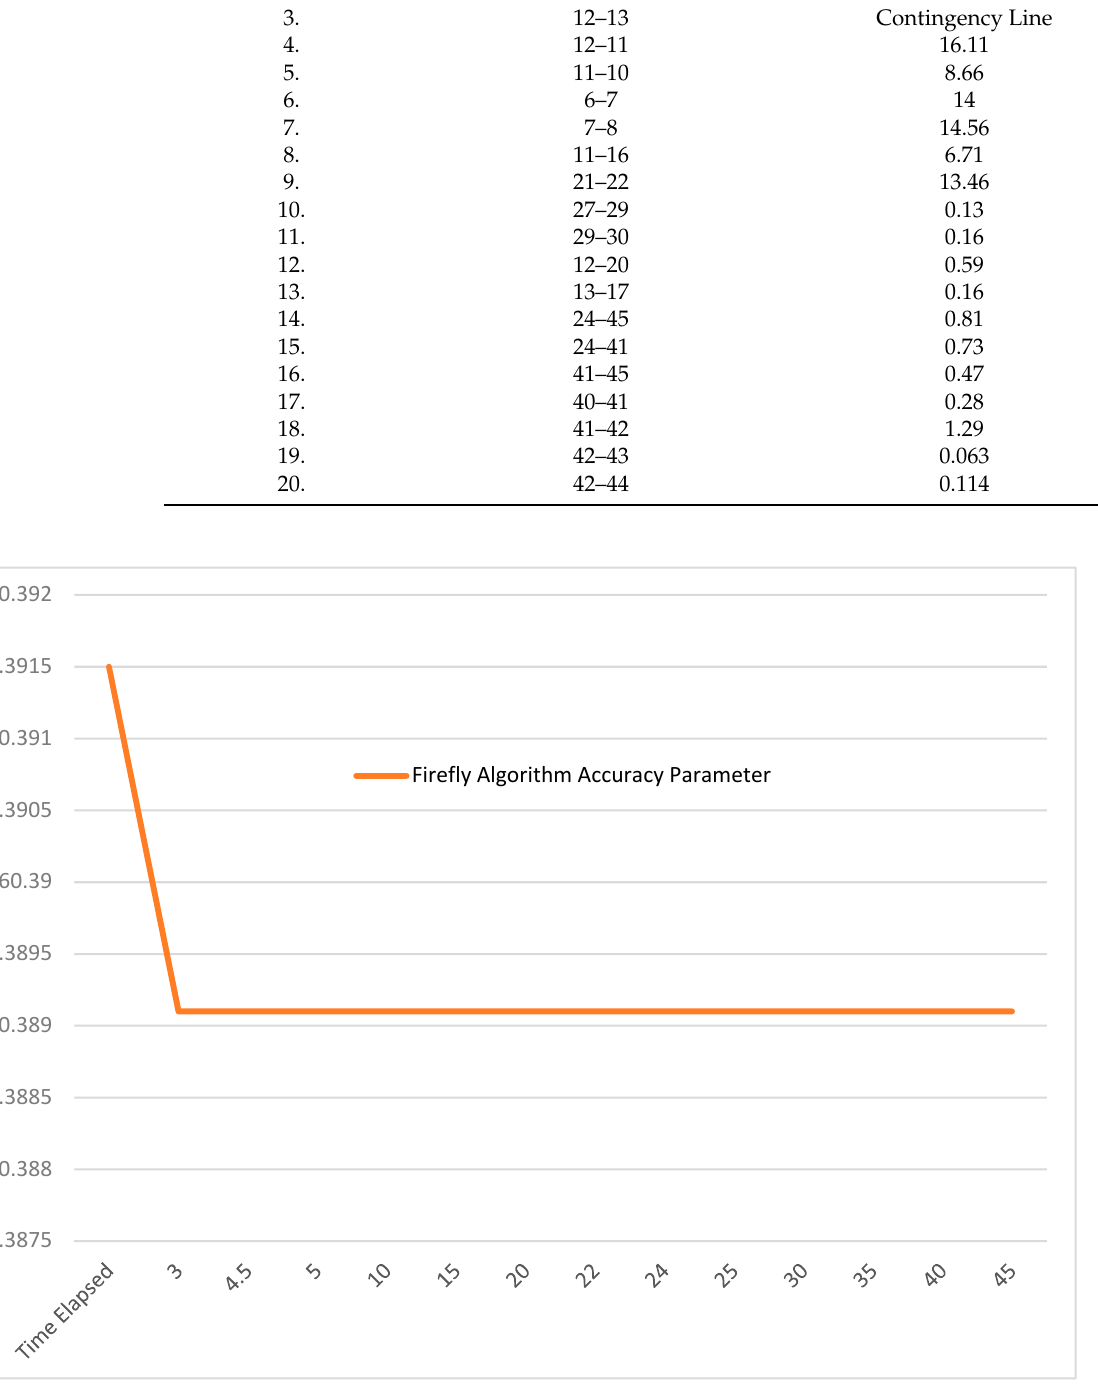
Figure 8. Time elapsed vs. accuracy for firefly algorithm.